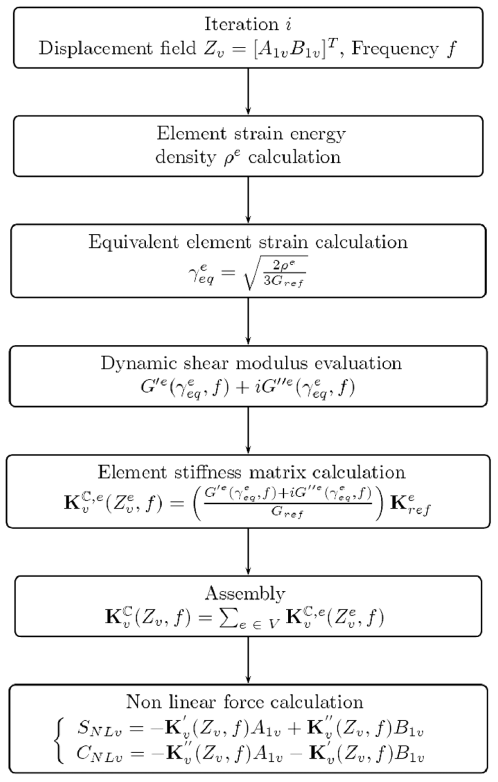
Fig. 2. Non linear force calculation for each iteration i